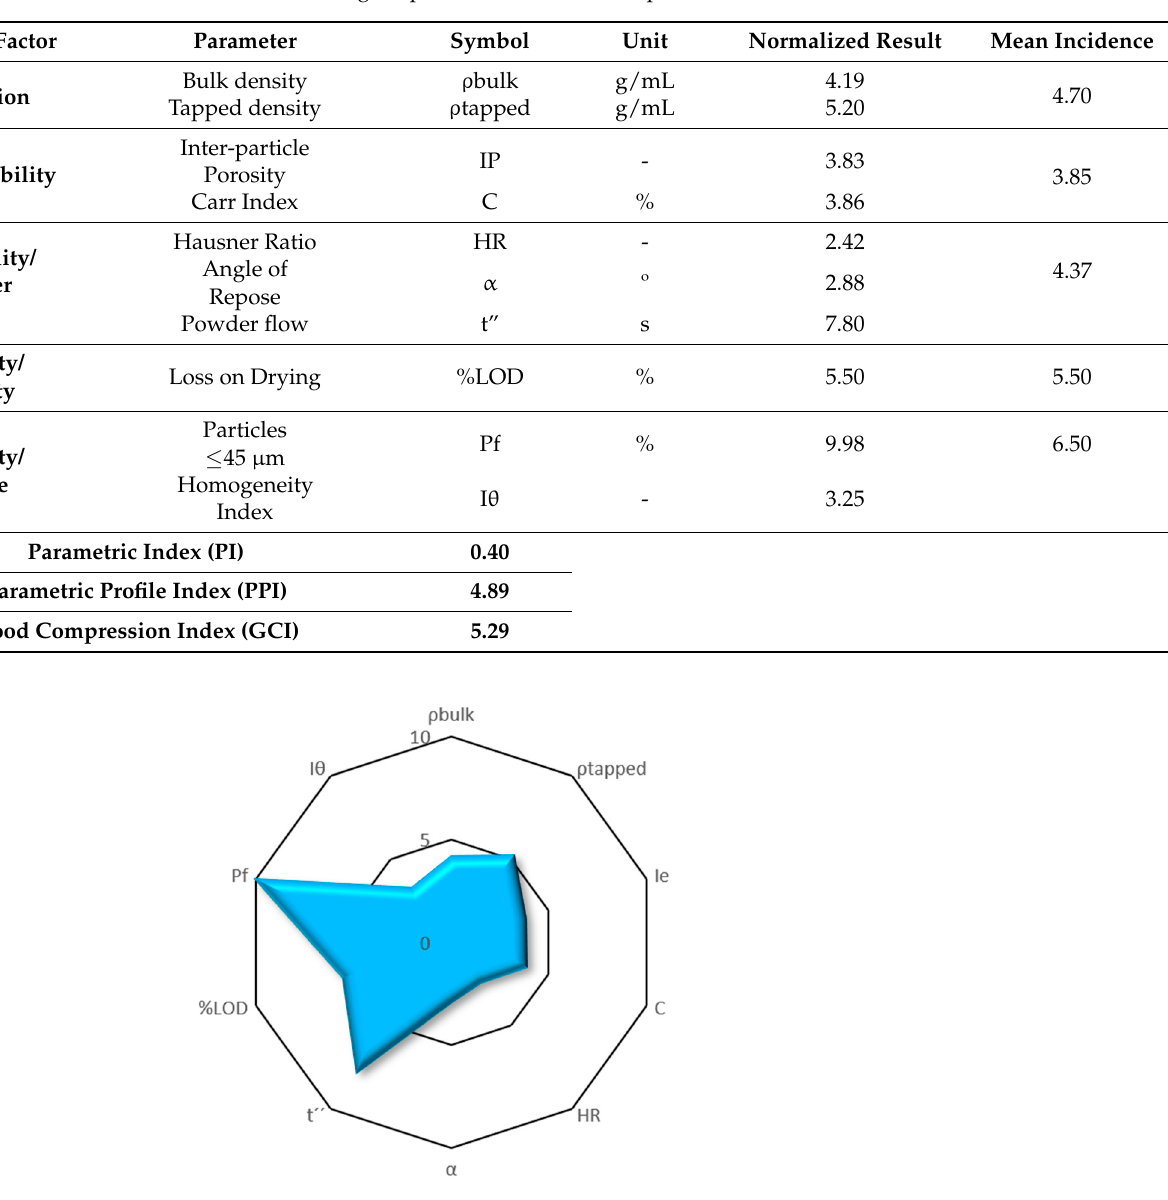
Table 2. Normalized results of rheological parameters for PBS_CL powder with the mean incidence values.